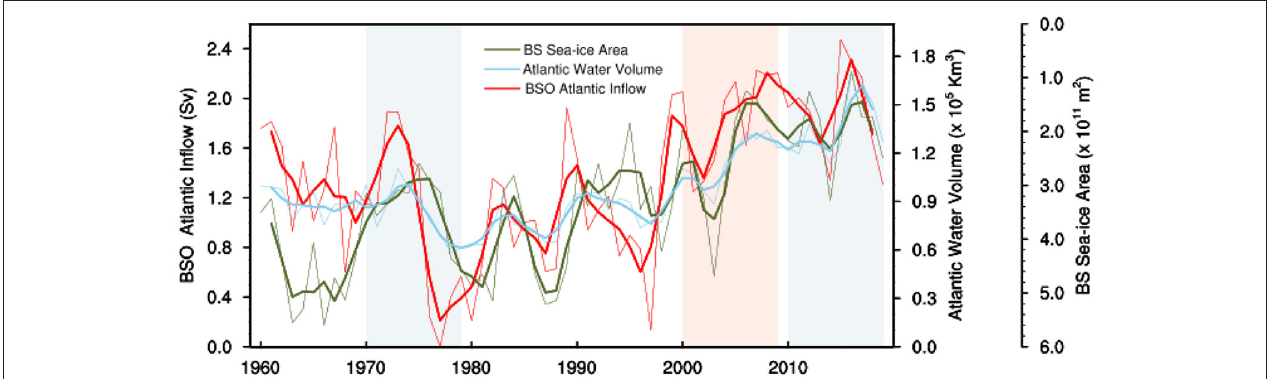
FIGURE 5 | Time series of modelled Atlantic Inflow (Sv) across the Barents Sea Opening (BSO, red), volume of Atlantic Water (Km 3 ) in the Barents Sea (blue) and total sea-ice area (m 2 ) in the Barents Sea (green). Following (Oziel et al., 2016), Atlantic Water is defined as water with T > 3.5 ◦ C and S > 34.8 within the Barents Sea. For each of the time series shown, light lines are annual means and bold lines are three-year running mean values. The shaded time periods highlight the time periods four years after the respective decadal trends in the